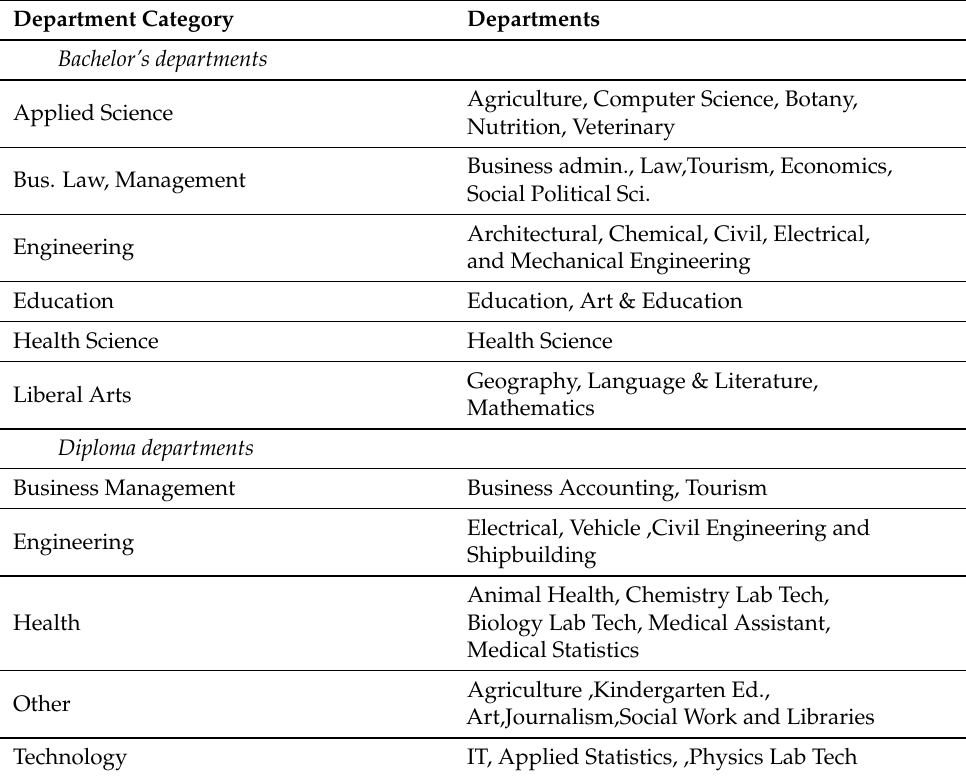
Table 8. Departments belonging to different categories, for bachelor’s and diploma